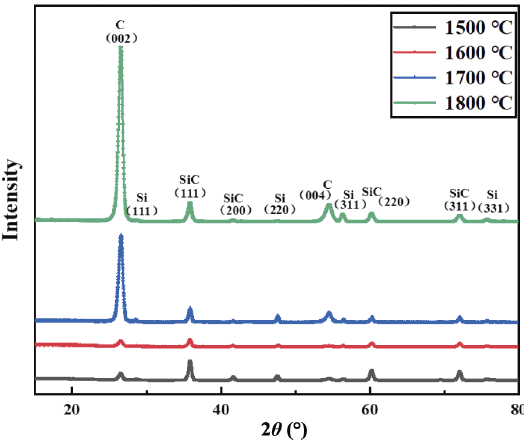
Fig. 8 XRD patterns of C pf /SiC composites prepared at different siliconization